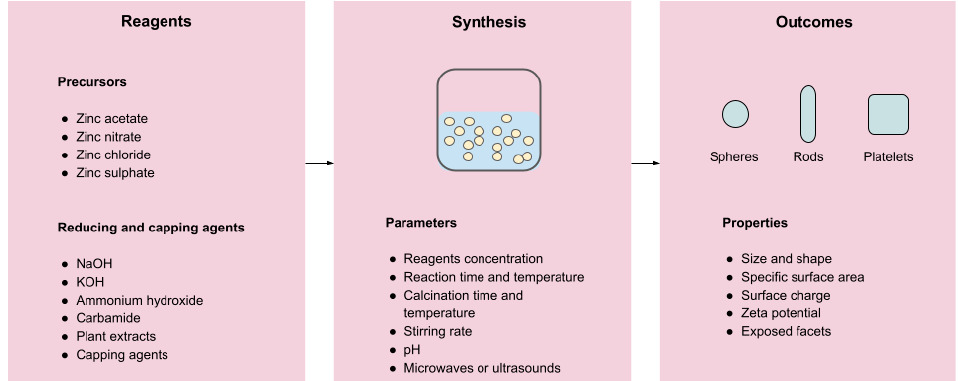
Figure 2. nZnO design through the selection of reagents and synthesis parameters.